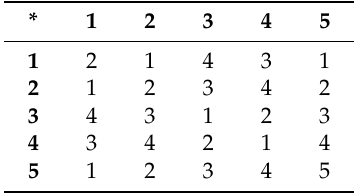
Table 8. Commutative perfect NETG.